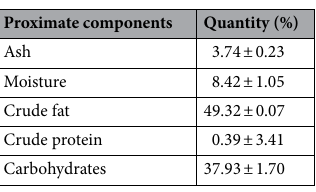
Table 1. Proximate components of C. schweinfurthii pulp